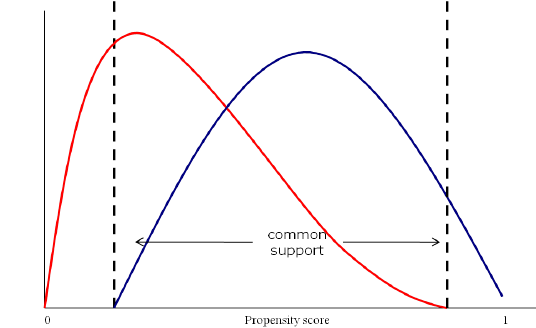
Figure 2. An example of a common Figure 1. An example of a common support 3